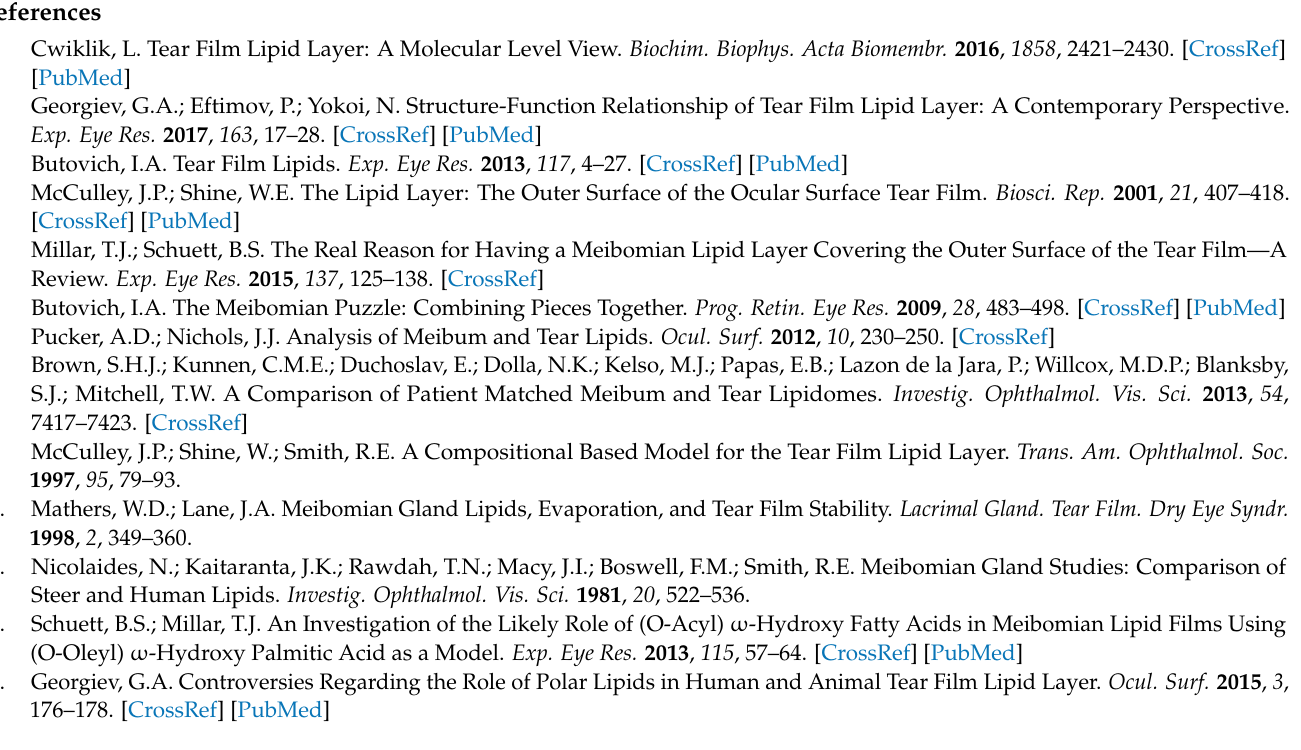
details; Figure S1: Criegee mechanism for ozonolysis of cholesteryl oleate; Figure S2: contrast, brightness and sharpness Enhanced BAM images of CO:PC 90:10 (binary mixture) and CO:GT:FFA:PC 40:25:15:20 (quaternary mixture) after ozone exposure; Figure S3: compression–expansion cycles of binary, ternary, and quaternary mixtures; Table S1: ESI-MS data for oxidized cholesteryl oleate; Table S2: ESI-MS data for oxidized glyceryl trioleate; Table S3: ESI-MS data for oxidized egg